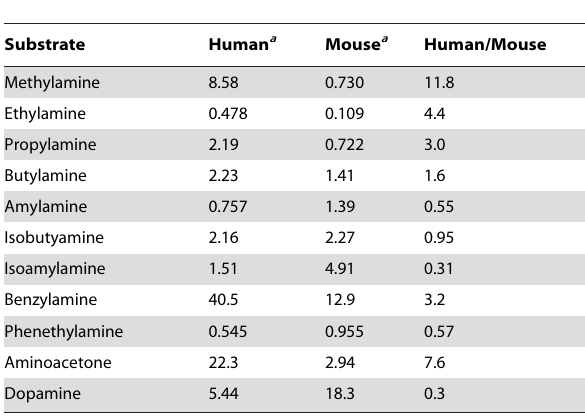
Table 3. Comparison of second order rate constants ( k cat /K m ) between purified human and mouse